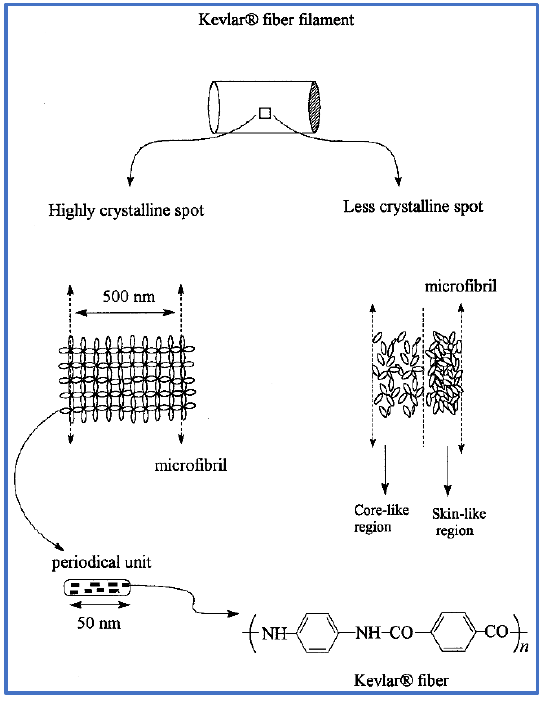
Figure 1. The microfibril and pleated appearance of periodical structure arrangements of aramid fiber [12]. Copyright 1999 Elsevier B.V (Amsterdam, The Netherlands).